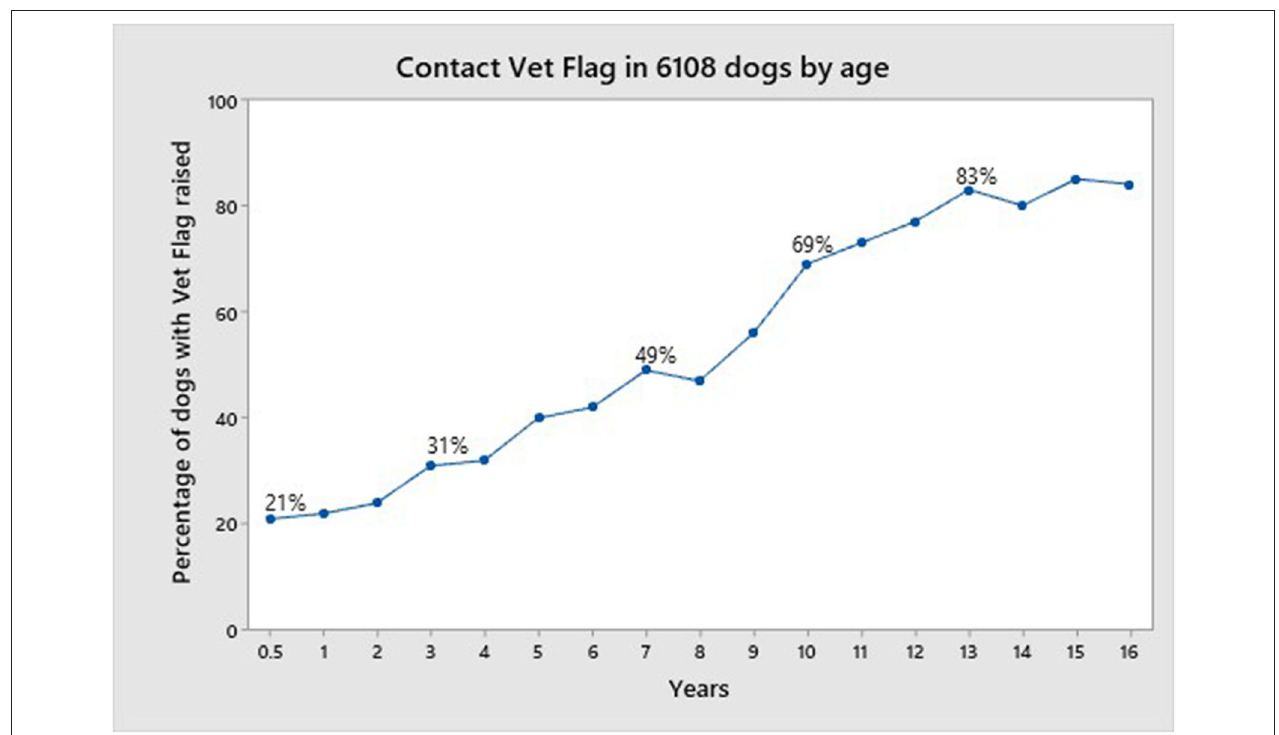
FIGURE 5 | Distribution of the Vet flag by